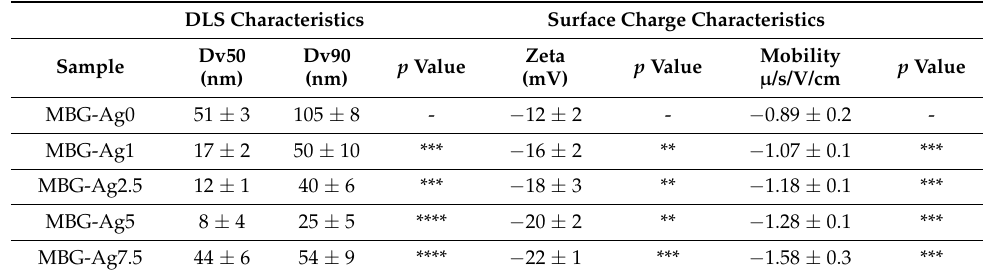
Table 3. DLS and surface charge characteristics of MBGs. (** p ≤ 0.01, *** p ≤ 0.001, **** p ≤